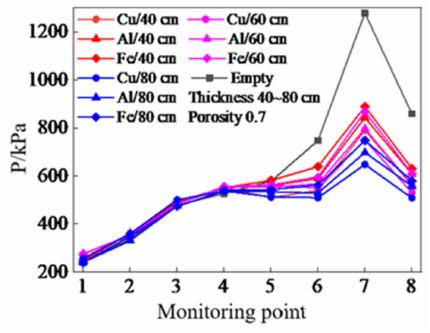
Figure 11. Maximum overpressure at each monitoring point.